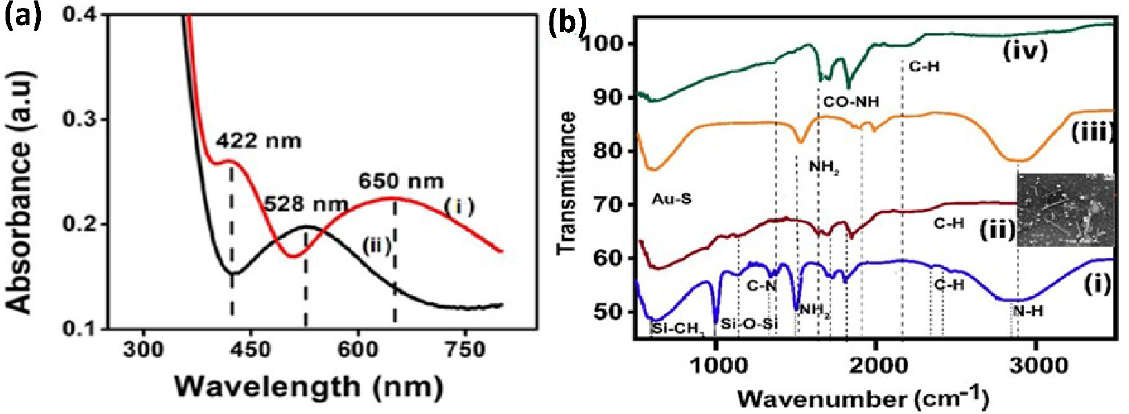
Figure 2. ( a ) UV-Visible Spectra of (i) Au Bilayer with absorption maxima at 528 nm (ii) AuNCs/APTMS/ITO with absorption bands at 422 nm and 650 nm. ( b ) FTIR Spectra of (i) APTMS/ITO electrode (ii) Cys/AuNCs/APTMS/ITO (iii) acTnI/Cys/AuNCs/APTMS/ITO electrodes obtained from 600 cm −1 to 5000 cm −1